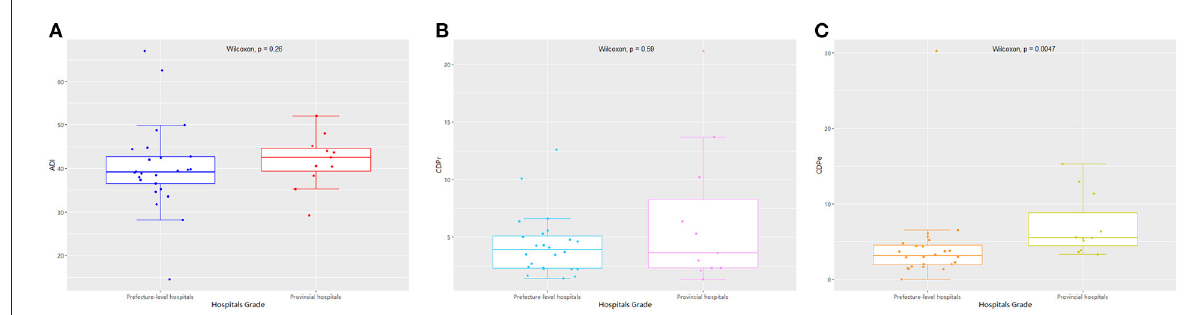
FIGURE5 The comparison of the measured drug use indices of GNRB at different hospital levels.